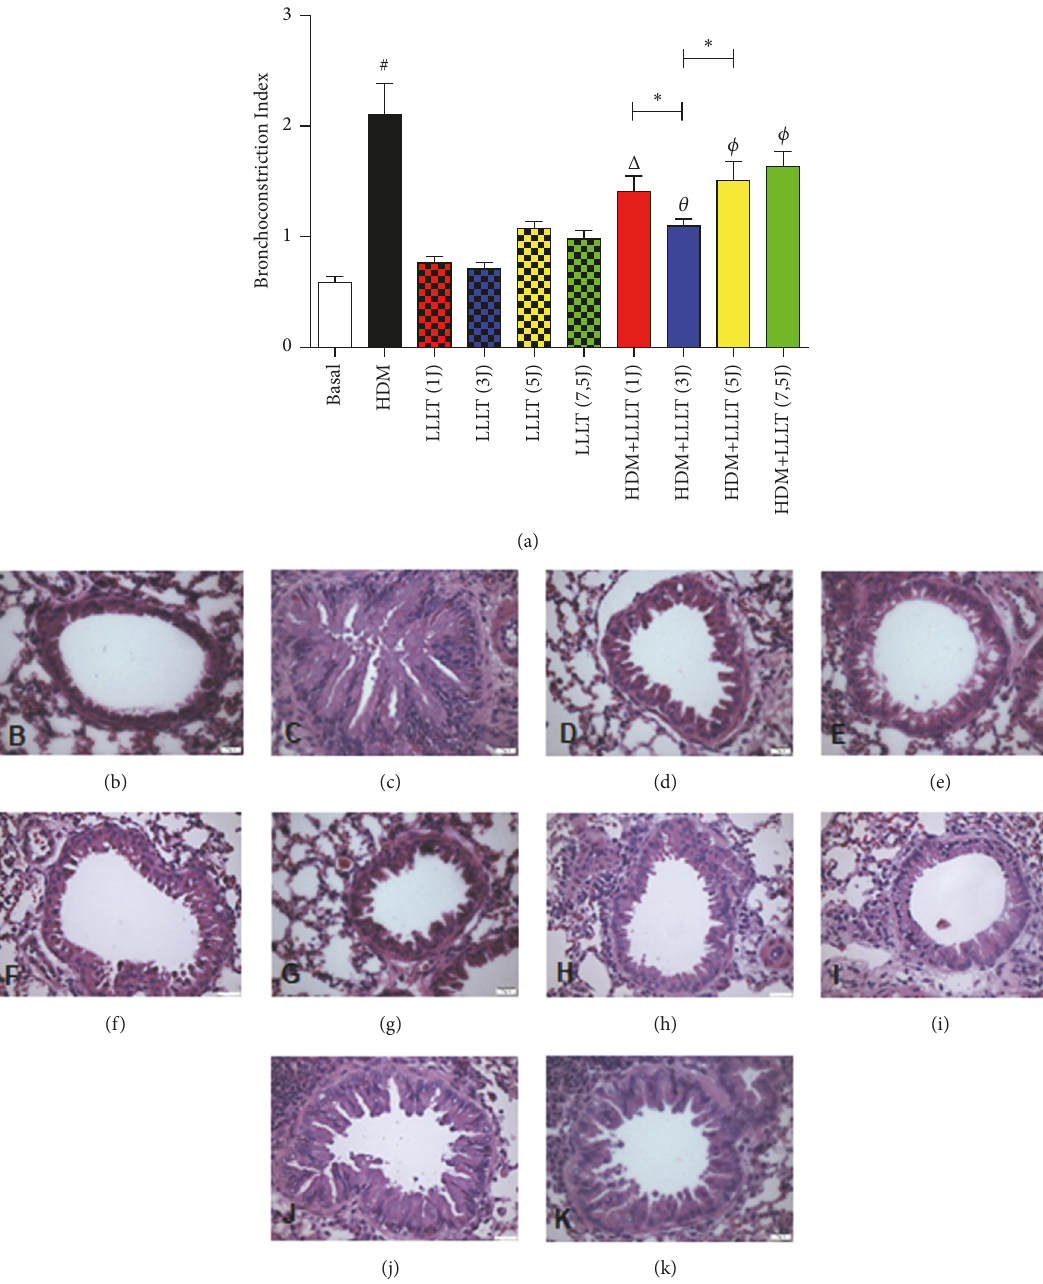
Figure 6: Effect of LLLT on bronchoconstriction index. The lungs were fixed, prepared and stained with HE for analysis of bronchocon- striction index in the airways. Increase of × 400. Values expressed as mean and standard deviation. The groups used in the experiment are described in Figure 1. The results refer to the use of 10 mice in each experimental group. # p < 0.001 when compared to the Basal group and 𝜃 p < 0.001, Δ p < 0.01, and 𝜙 p < 0.05 when compared to the asthmatic group (HDM); ∗ p < 0,05 when compared HDM+LLLT (3J) group with the other groups treated with other